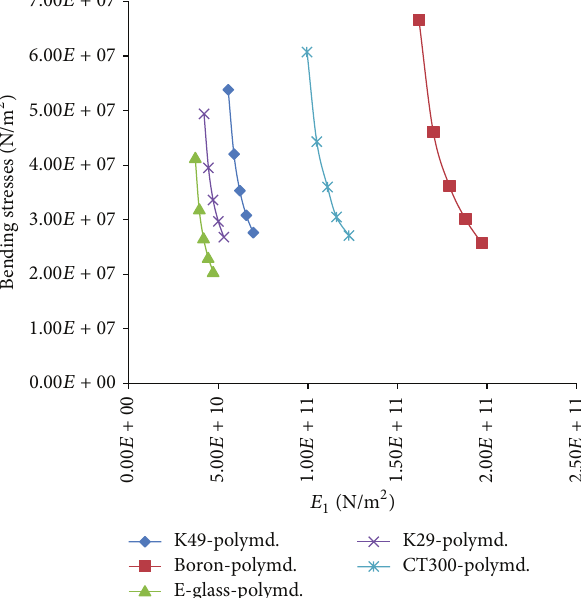
Figure 17: Effect of longitudinal modulus of elasticity on leaf spring deflection of various composite leaf springs based on fiber type.